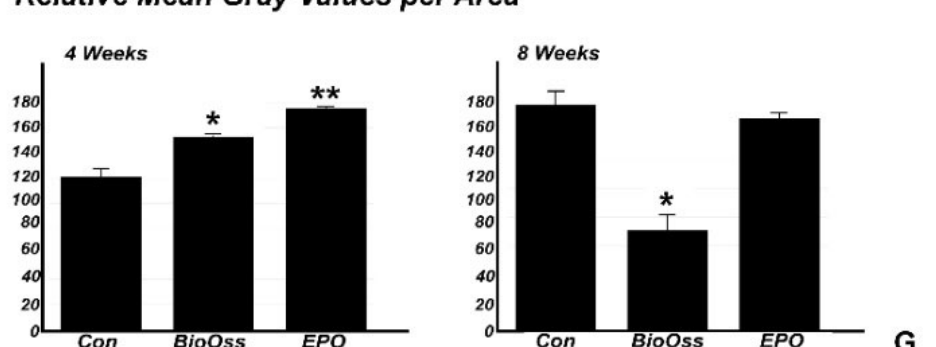
Figure 1. ( A – F ) X-Rays of 4 weeks ( A – C ) and 8 weeks ( D – F ) post-surgery rat maxillae following treatment with collagen membrane alone ( A , D ), BioOss ( B , E ) and EPO impregnated collagen sponge ( C , F ). Note the high radio-opacity in the EPO treatment groups 4 and 8 weeks after surgery ( C , F ) compared to the BioOss ( B , E ) and the collagen membrane control group ( A , D ). The graph in ( G ) revealed the significant difference in the mean grey value at 4 weeks indicated by * ( p < 0.05) between the control and the Bio-Oss group and between the control and the EPO treated group ( p < 0.01) indicated by **. At 8 weeks, the mean grey value was significantly lower in the Bio-Oss group compared to the control and EPO treated group ( p < 0.05) indicated by *. The position of the rat maxillary molars is indicated as m 1 , m 2 , and m 3 , and the extraction site is demarked with a double arrow. The radio-opacity indicative of mineralization in the collagen/EPO treatment group was significantly higher than in the collagen membrane control group and in the Bio-Oss group 4 weeks after surgery.